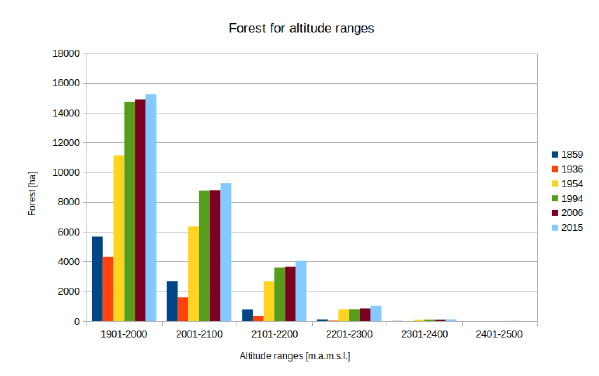
Figure 15. Forest coverage evolution distribution for different altitudes in the Trentino region from 1859 to 2015.